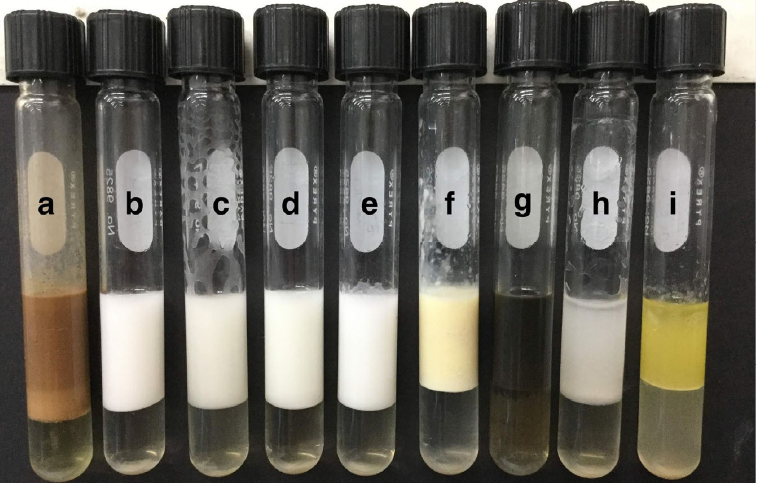
Figure 6. Emulsifying index obtained with different hydrocarbons using CL 84 produced by Bacillus subtilis subsp. spizizenii MC6B-22. ( a ) Burnt motor oil, ( b ) Toluene, ( c ) Xylene, ( d ) Diesel, ( e ) n -Hexadecane, ( f ) Motor oil, ( g ) Crude oil (Petroleum), ( h ) n -Hexane, ( i ) Olive oil. Table 6. Emulsifying activity EI 24 (%) of CL 84 produces by Bacillus subtilis subsp. spizizenii MC6B-22 in presence of different hydrophobic substrates.